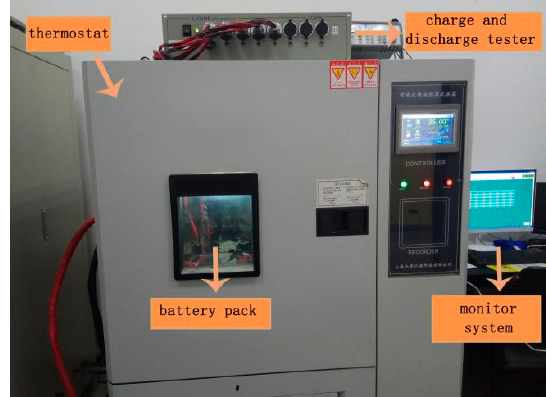
Figure 5. Data acquisition platform (the battery is in thermostat).